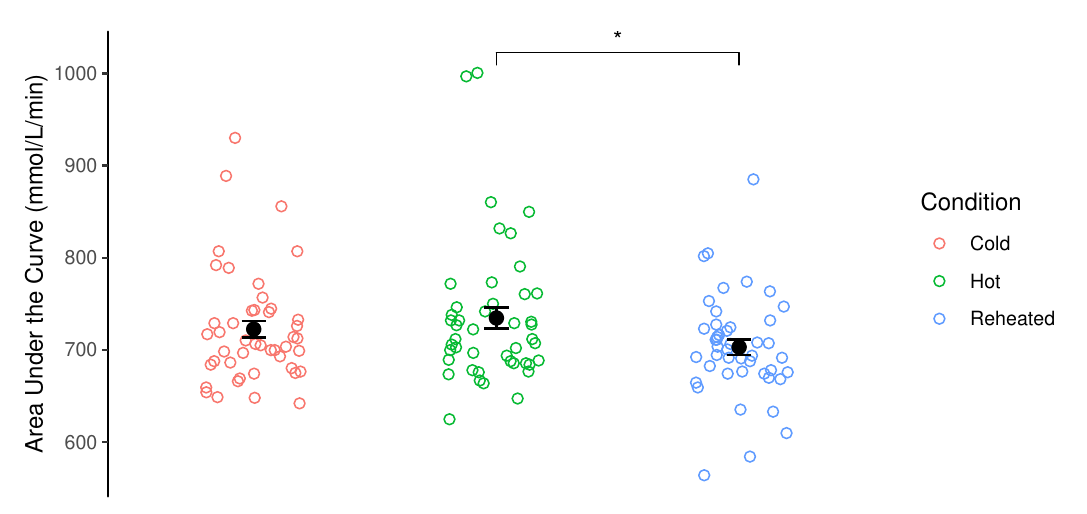
Figure 1. Area under the curve for post-prandial glucose response to three different carbohydrate meal preparations. Data shown is mean ± standard error alongside individual responses. * denotes significant difference between groups ( p <